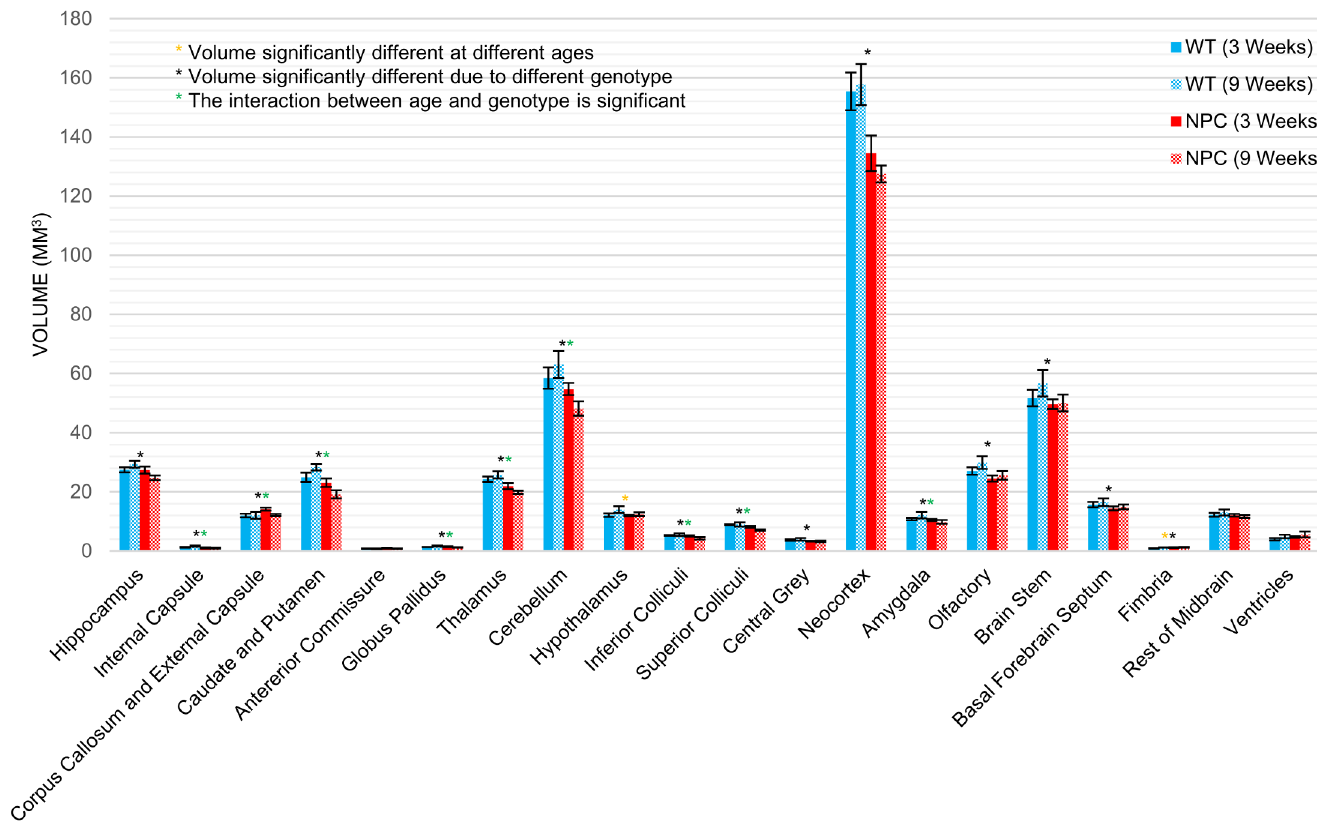
Fig 3. Results of whole-brain segmentation volumes. Volumes of twenty mouse brains regions are shown for WT mice (blue) and Npc1 -/- (red) mice at 3 (dark) and 9 (light) weeks of age. Error bars indicatethe standard deviationwithin groups. Significant effects of genotype( * ) and age ( * ) and significant interaction betweenage and genotype( * ) were determinedfrom a two-way ANOVA and p < 0.05after Holm-Bonferroni correction.